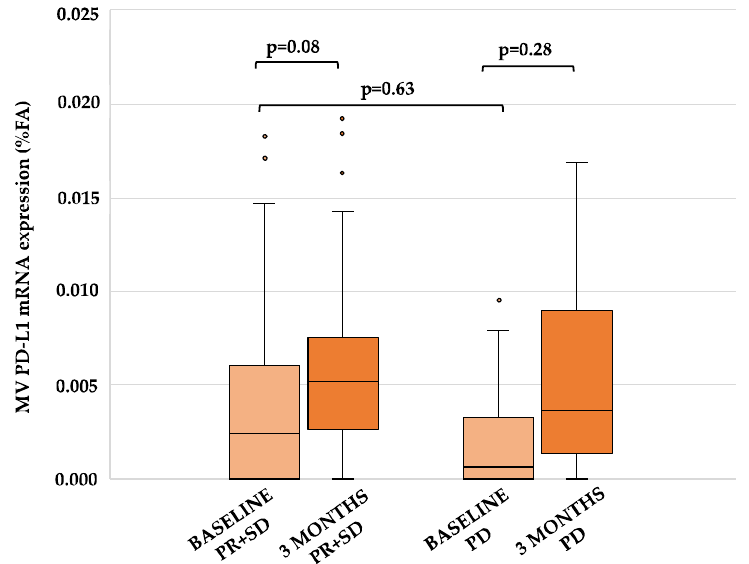
Figure 2. Effect of chemotherapy on PD-L1 mRNA levels and clinical response in PDAC patients. The amount of PD-L1 mRNA (FA) at baseline (light orange) and at tumor re-assessment after 3 months of treatment (dark orange) was grouped according to tumor response (PR + SD and PD); p values are reported on top of the bar chart. Abbreviations: PD-L1, programmed death-ligand 1; FA, fractional abundance; PR, partial response; SD, stable disease; PD, progressive disease.